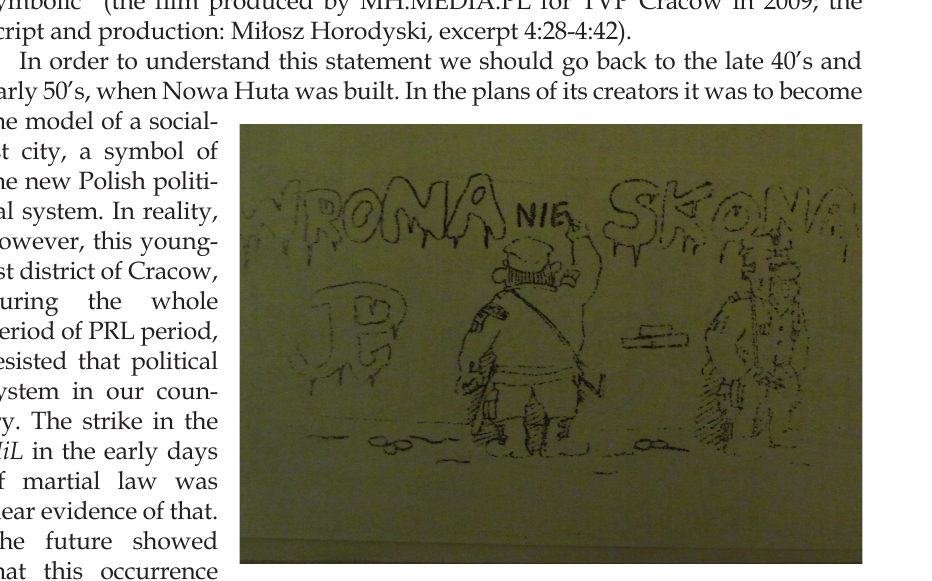
Fig 4. WRONA nie SKONA Source: Satyra stanu wojennego